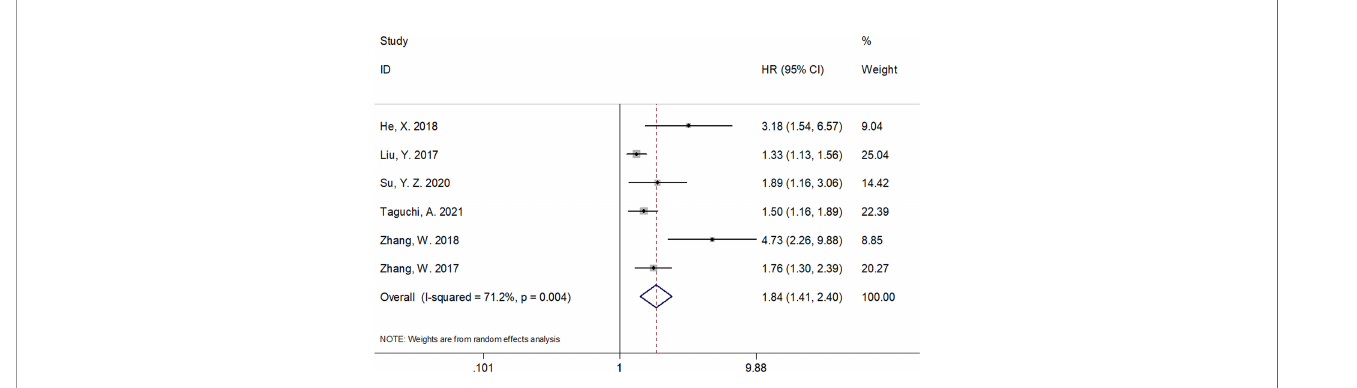
FIGURE 2 | Forest plots of studies evaluating the hazard ratio for overall survival (OS) of patients with gynecological cancers of a high CRP/Alb ratio.